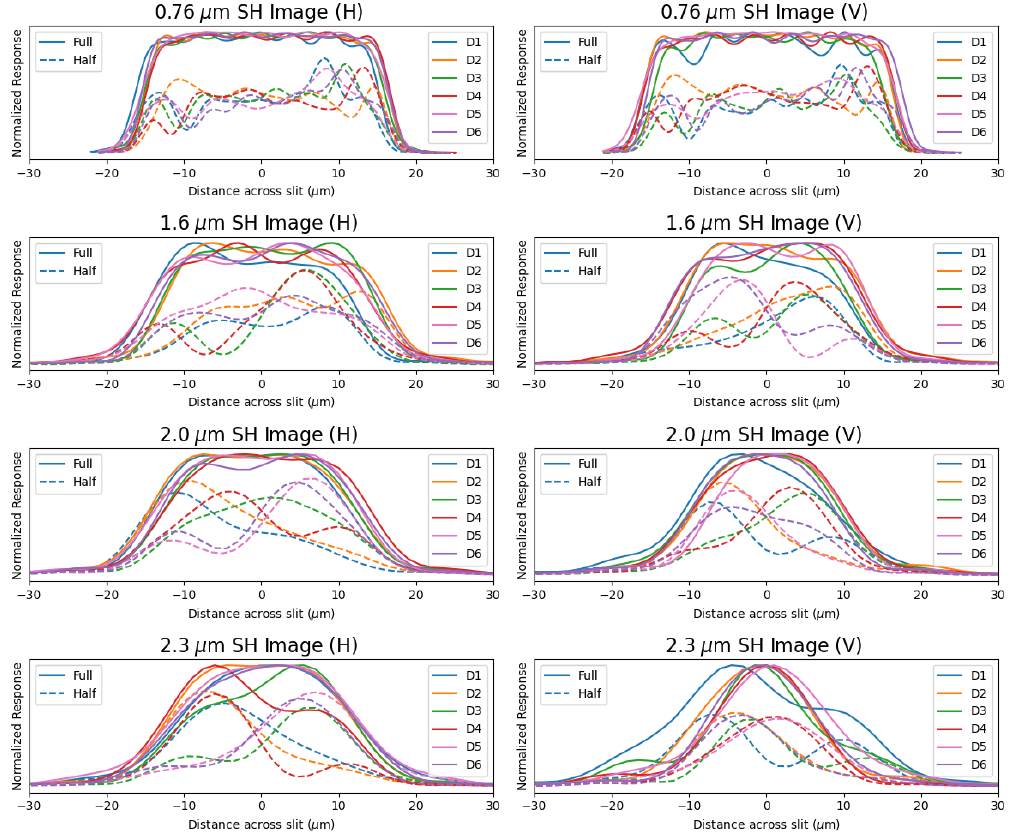
Figure 9. Across-slit illumination as a function of slit position for horizontally (left column) and vertically (right column) polarized light. The colors represent the different devices (D1–D6) detailed in Table 2. Solid lines depict fully illuminated scenes, normalized to the maximum value, while dashed lines represent the illumination pattern resulting from 50% of the illumination being blocked by a knife edge (normalized by the maximum value of the corresponding fully illuminated slit image), which is apparent from the lower signal in the dashed lines.